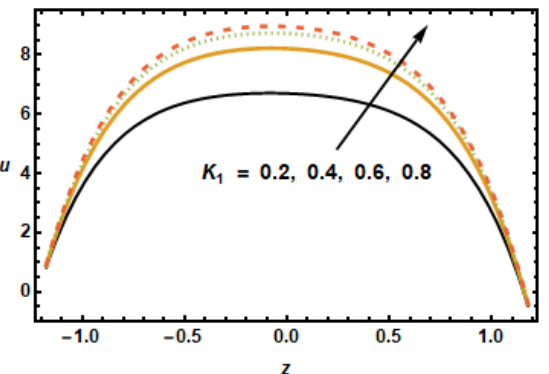
Figure 4. Effects of permeability K 1 on u